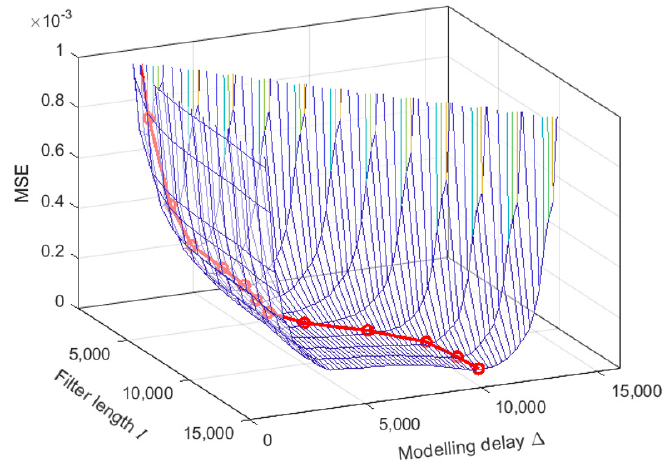
Figure 9. MSE surface against filter length I and modelling delay ∆ , and the minimum MSE at each I (the thick line with circles).